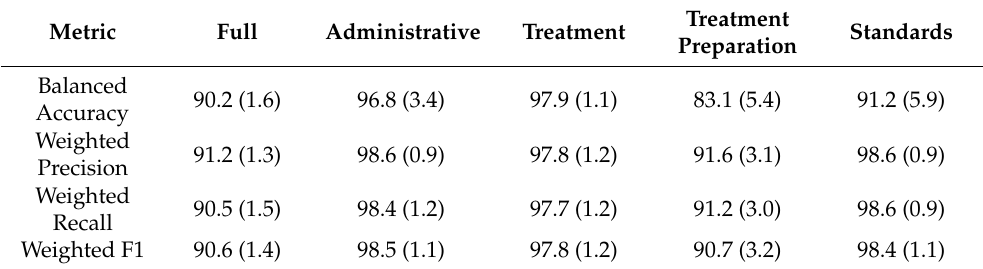
Table 2. Model performance on test data with tf-idf + LSA + Linear SVM.